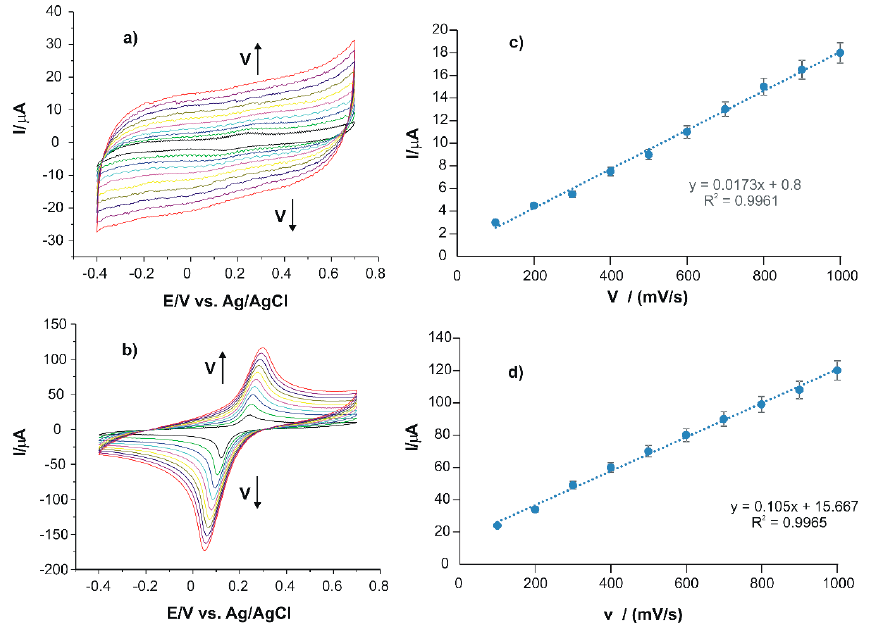
Figure 4. Cyclic voltammograms of SPCE ( a ) or PB/SPCE ( b ) immersed in a double solution 10 − 4 M diosmin/KCl 10 − 1 M, recorded with various scan rates in the range 0.1–1.0 V · s − 1 . The dependence between the values of the current of the anodic peak and the scan rate for SPCE ( c ) and PB/SPCE ( d